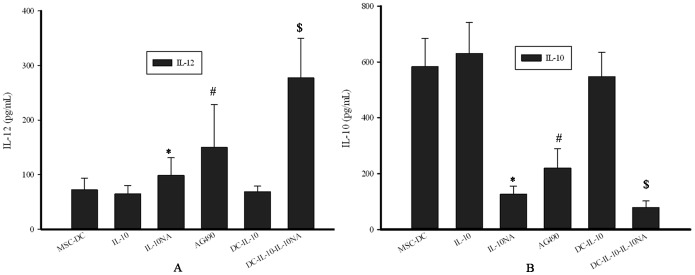
ELISA analysis of co-cultures of MSC-DC supplementated with exogenous IL-10, IL-10NA and JAK inhibitor (AG490).IL-10 and IL-12 levels in DC–IL-10 and DCs -IL-10 -IL-10NA group by ELISA. (A) IL-12; (B) IL-10.* P<0.05 (IL-10NA group versus MSC-DC group), # P<0.05 (AG490 group versus MSC-DC group), & P<0.05 (DC- IL-10 group versus MSC-DC group), § P<0.05 (DC- IL-10-IL-10NA group versus IL-10NA group),$ P<0.05 (DC- IL-10-IL-10NA group versus DC- IL-10 group).